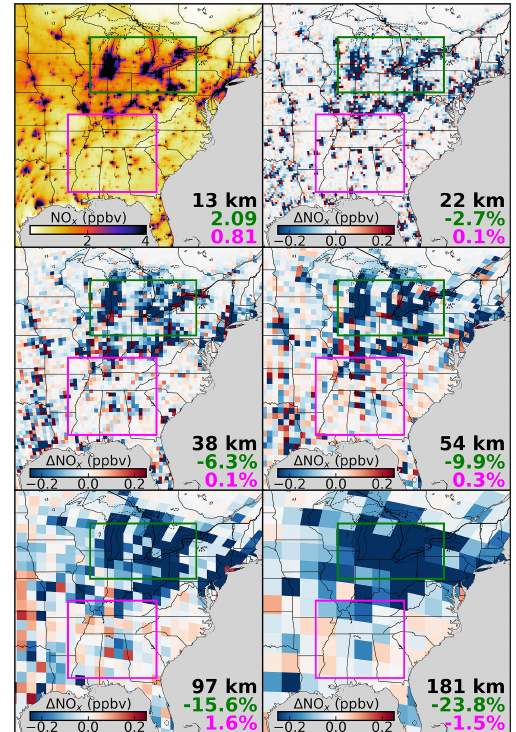
Figure A3. Similar to Fig. 1c but for morning (13:00–18:00UTC or 07:00–12:00CST) NO x .